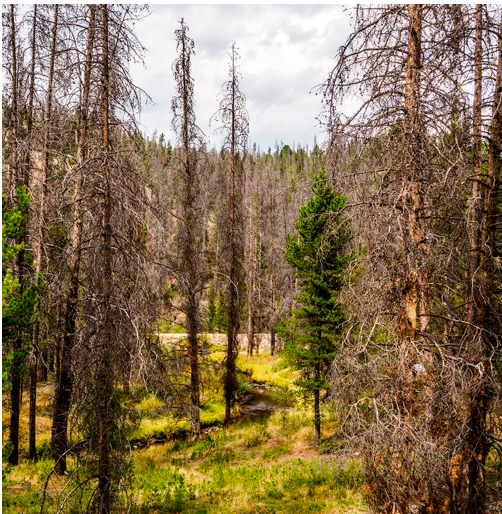
Figure 15. Lodgepole Pine ( Pinus contorta ) killed by Mountain Pine Beetle ( Dendroctonus ), Montana, USA. This beetle only attacks certain Pinaceae species [36].